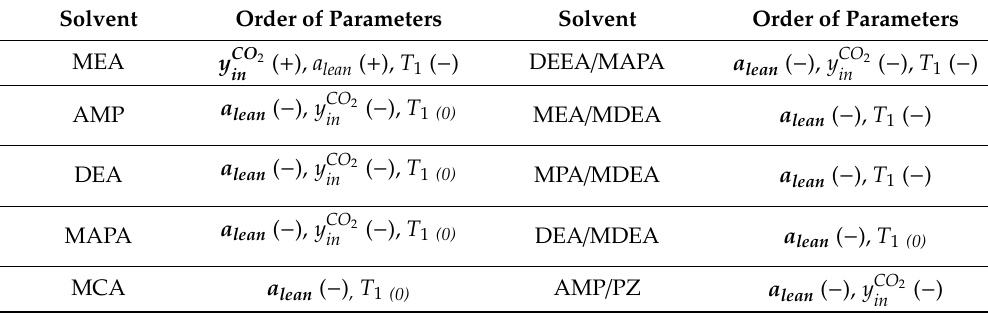
Table 5. Ranking of the parameters that a ff ected Q regen , m am , and ∆ α , with descending eigenvector entries from left to right. The highest absolute values are shown in bold. Underlined symbols indicate the eigenvector direction that corresponded to the second-largest eigenvalue, which is of a similar order of magnitude as the highest eigenvalues. The signs in brackets indicate the directions of change for the parameters (opposite signs indicate a change in the opposite direction).